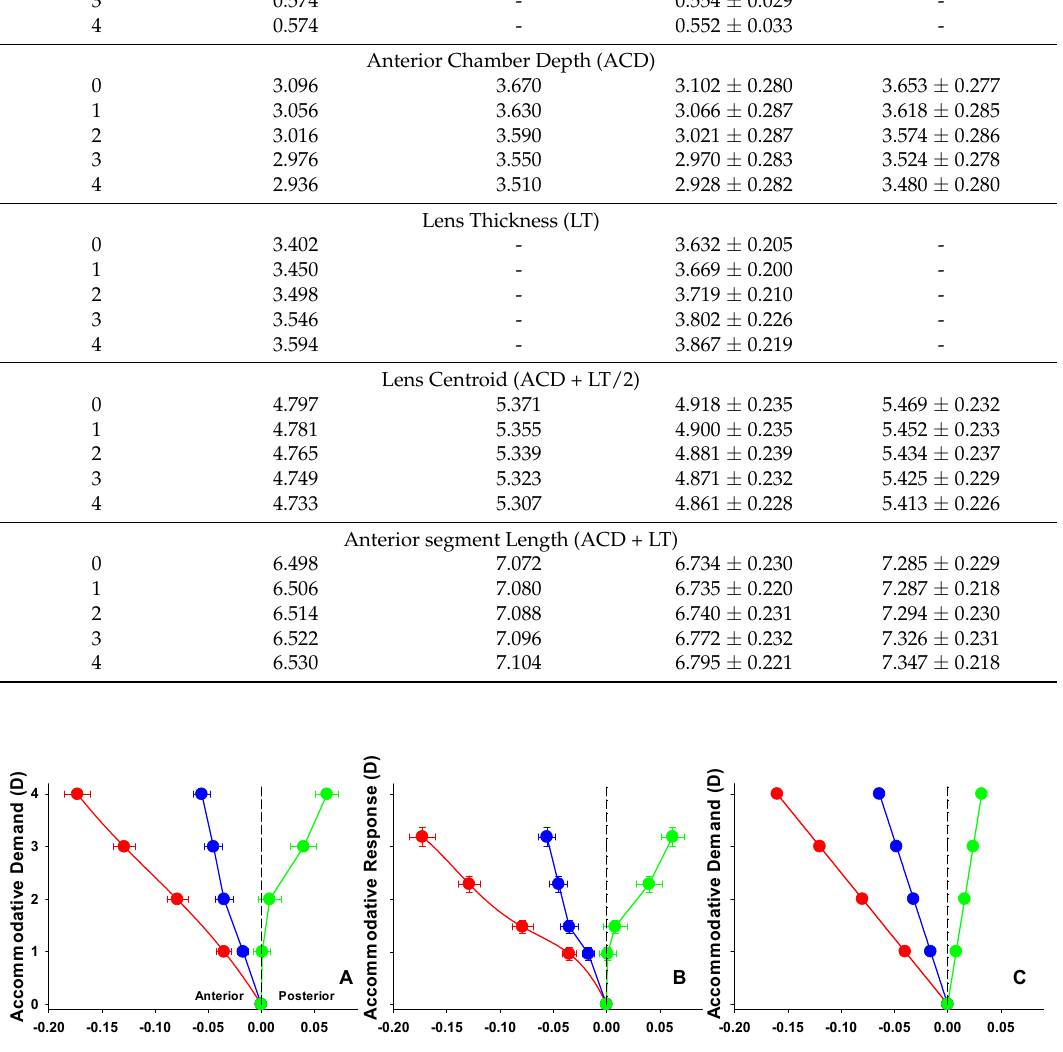
Figure 2. Relative movements of the various lens parameters as a function of accommodative demand or response. Red markers represent the anterior lens surface, blue markers the lens centroid and green markers the posterior lens surface. ( A ) The relative movement of the lens components for the AS ‐ OCT data with accommodative demand (error bars represent ±SEM). ( B ) The relative movement of the lens components for the AS ‐ OCT data with accommodative response (±SEM). ( C ) The relative movement of the lens components for the Dubbelman model eye [65] with accommodative demand.